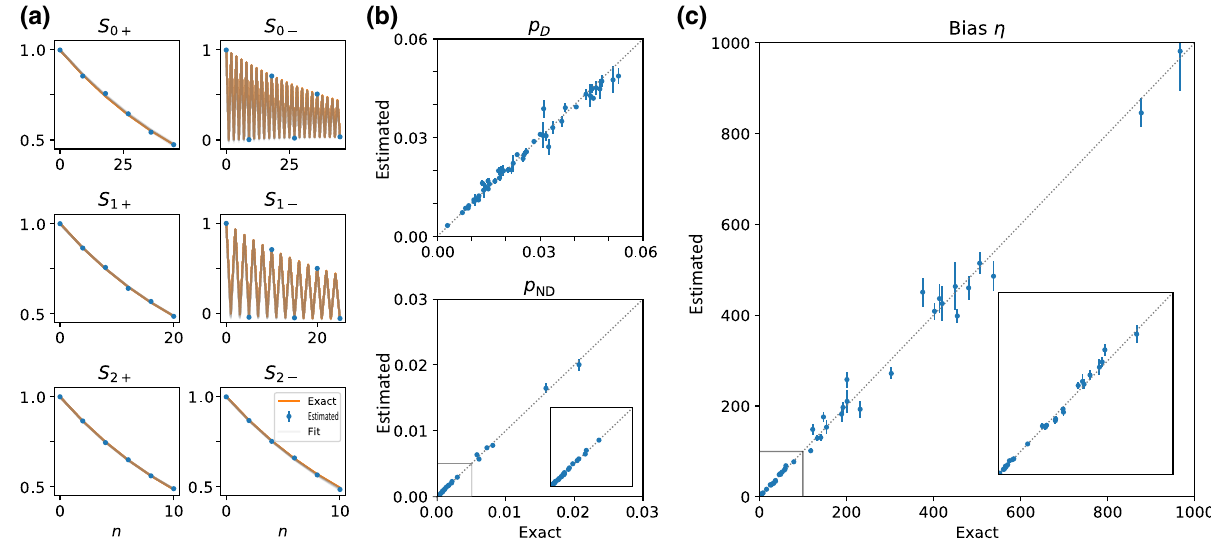
FIG. 2. Simulated interleaved-bias-RB experiments. (a) An example of estimating S b ( n ) , with the S b ( n ) curves plotted in orange and our estimates of S b ( n ) given by blue dots. Note that S b ( n ) is oscillatory for b = 0 − , 1 − , since the decay constants λ b and κ b have opposite sign. To robustly fit S b ( n ) in the presence of these oscillations does not require densely sampling data points, since we know the oscillatory period is always 2; however, it does require taking data at both even and odd sequence lengths, as shown in the figure. To estimate sensitivity to statistical errors, we generate multiple fits of S b ( n ) using bootstrap resampling of our data, which are plotted in gray and generally overlap the exact S b ( n ) curves. (b) The probabilities p D and p ND extracted from the fits for 50 randomly generated error channels. The error bars denote the standard deviation over 50 resamplings. (c) The estimated bias η for each of these error channels. We see that even at very high bias, we can accurately estimate the value of η